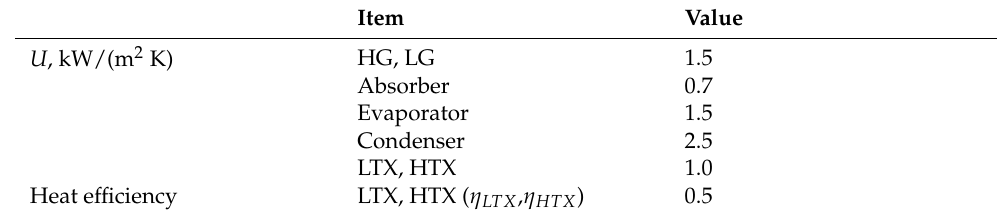
Table 2. Heat-transfer coefficient and heat efficiency for each component